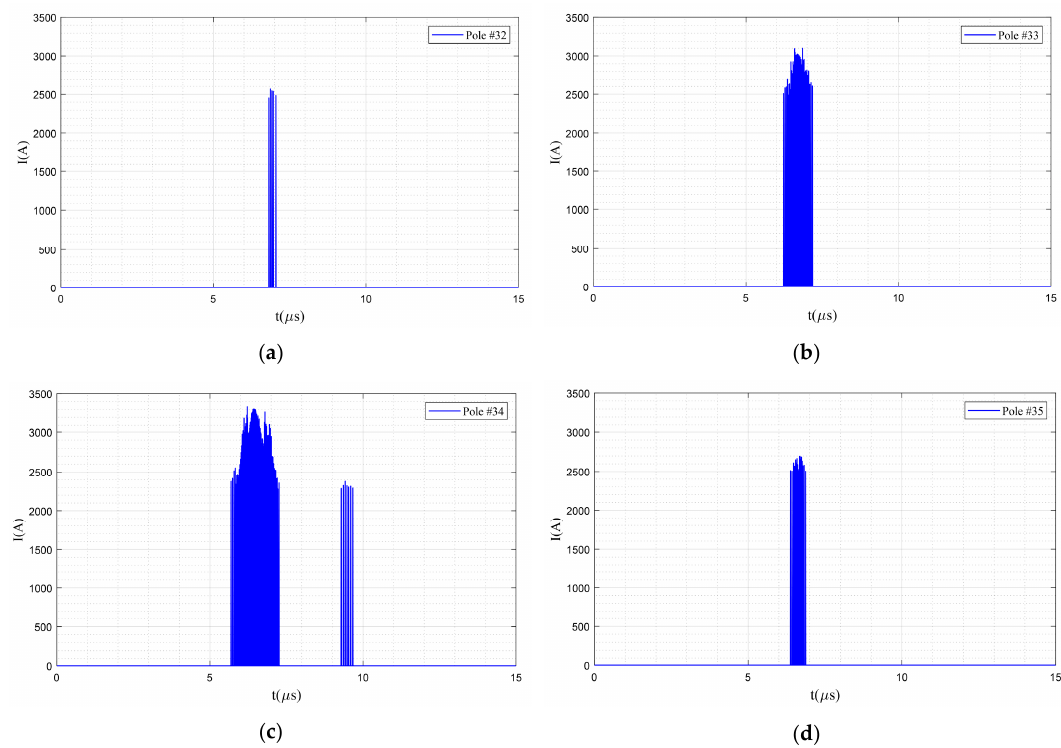
Figure 21. Flashover discharge currents of four intermediate poles supported by guy wires: ( a ) Intermediate Pole #32, ( b ) Intermediate Pole #33, ( c ) Intermediate Pole #34, and ( d ) Intermediate Pole #35; Network with dry poles and direct lightning applied on pole #34.